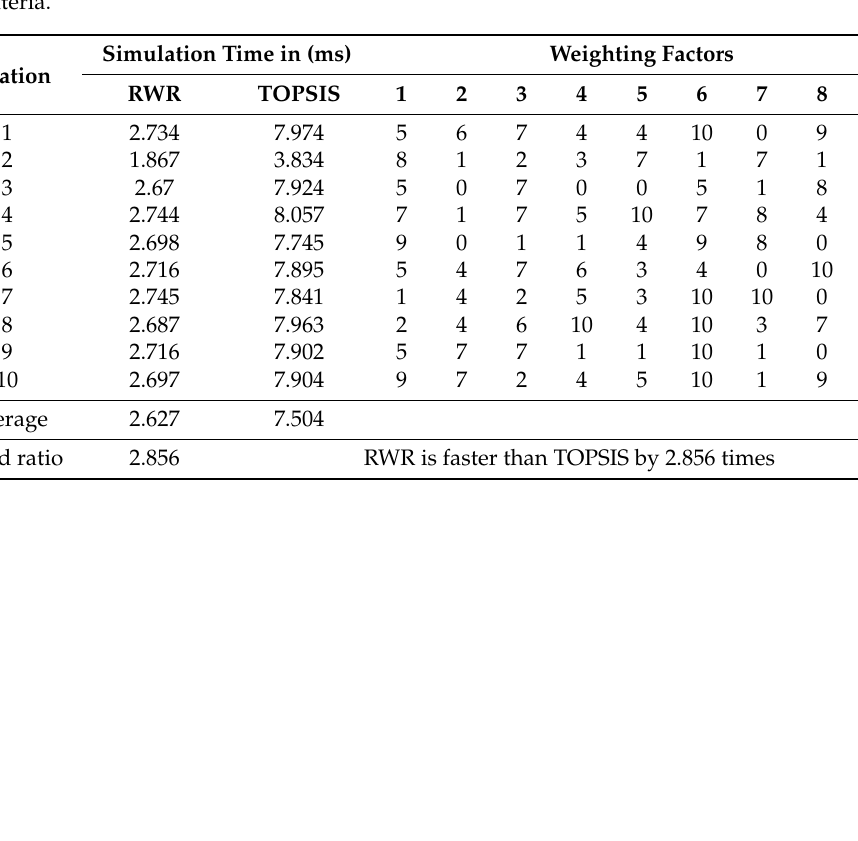
Table 6. Simulation time comparison between RWR and TOPSIS for the same number of alternatives and